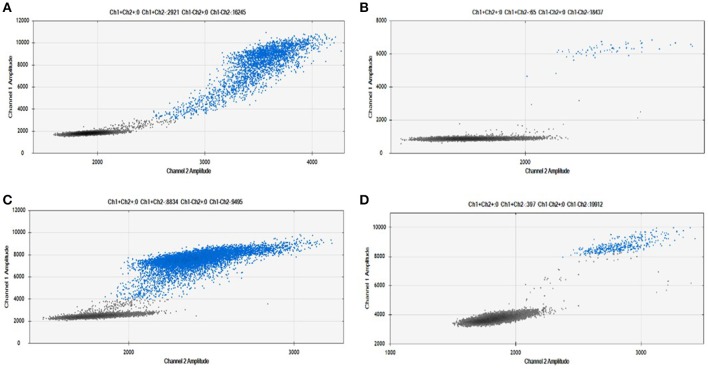
Positive droplet selection in 2D Plot. Bi-dimensional droplet plots of four illustrative miRNA assays: (A) RNU6, (B) miR-149-5p, (C) miR-24-3p, and (D) miR-210-3p. Droplet clouds could have different appearance and shapes, but droplet positive selection is always possible.